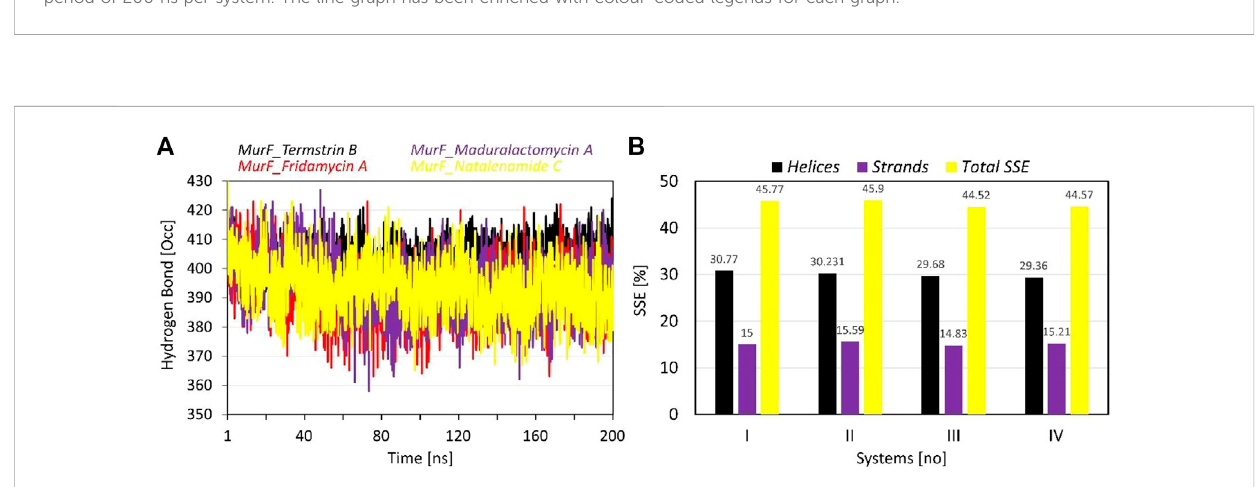
FIGURE 6 Theplotsshowtheresultsof (A) intra-proteinhydrogenbondoccupancy,and (B) Secondarystructureelements(inpercentages)analysisduringthe simulation time of 200 ns per system. The line graph has been enriched with colour-coded legends for each